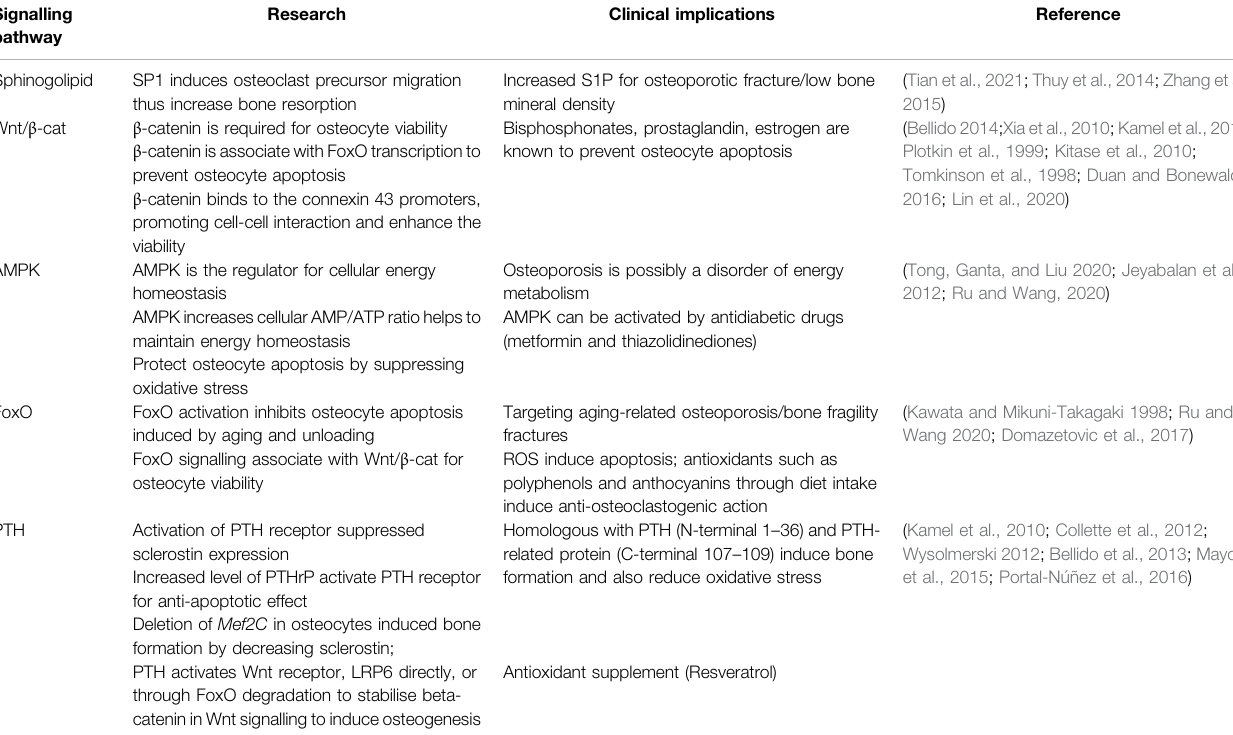
TABLE 2 | The key research demonstrations for mechanosensitive signalling pathways in osteocytes and therapeutic implications. Signalling